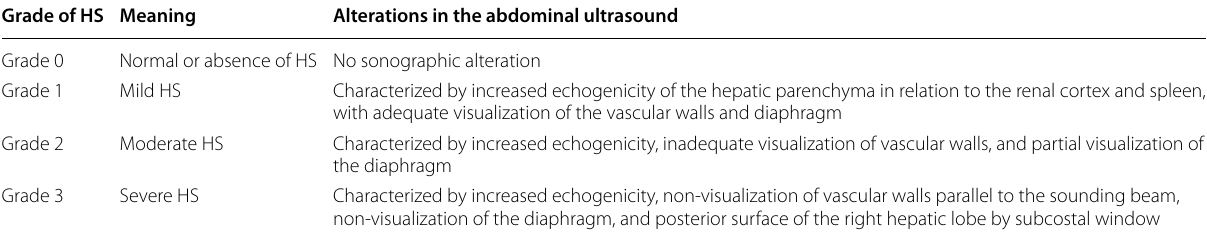
Table 1 Degree of hepatic steatosis according with alterations found in the abdominal ultrasound (Ferraioli and Monteiro 2019; Hamaguchi et al.